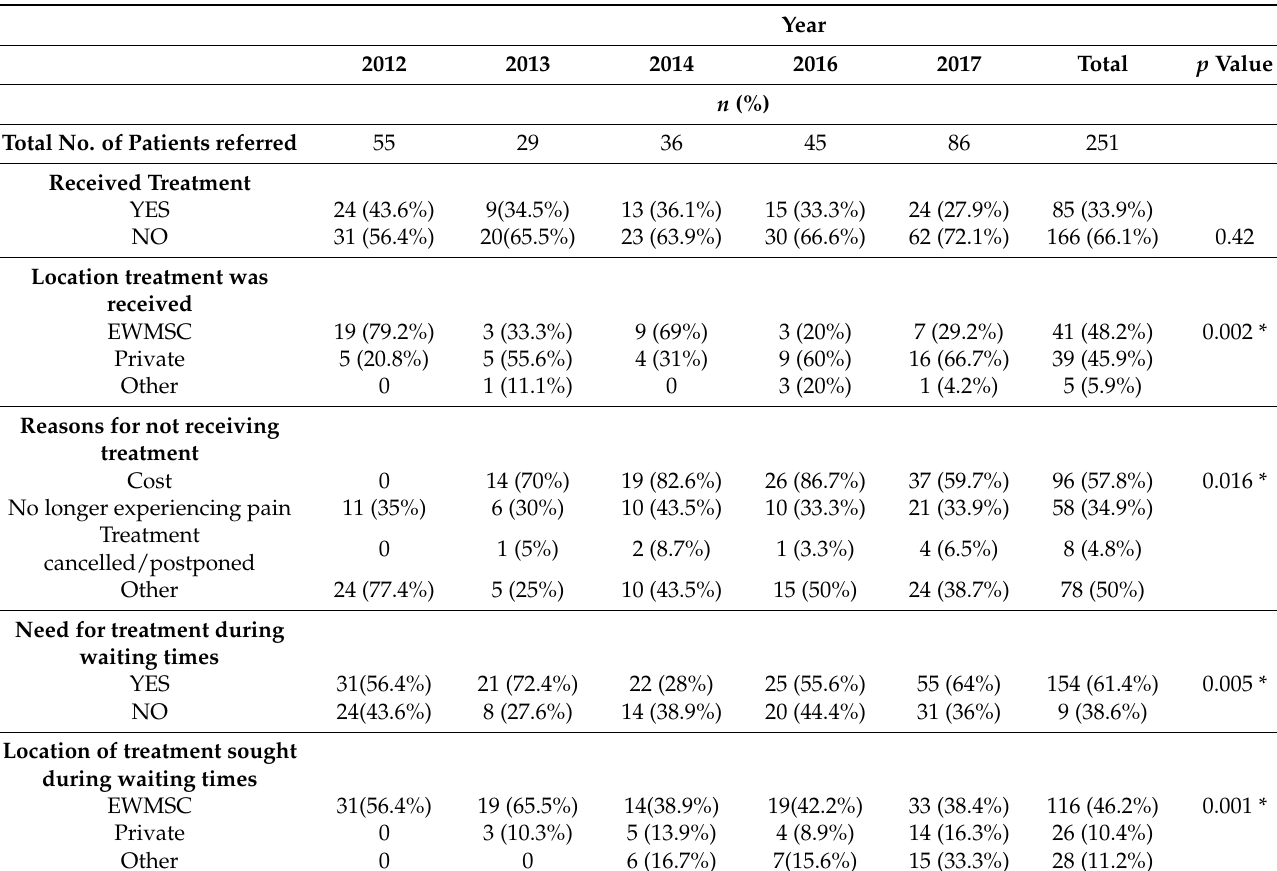
Table 4. Treatment outcomes for patients referred for GA/sedation by year.